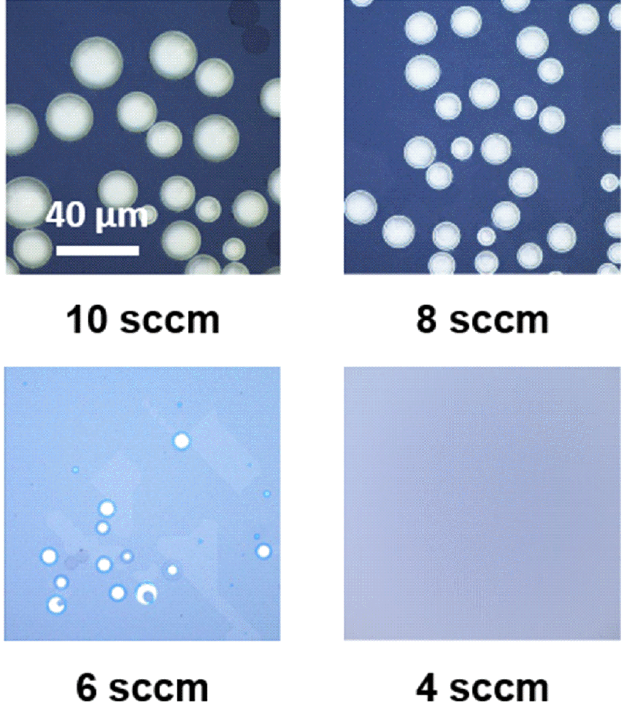
Fig. 1. Confocal images of the surface of SiO x \(p) m c-Si:H samples after fi ring step (Batch 1) for different R =H 2 /SiH 4 ratios.